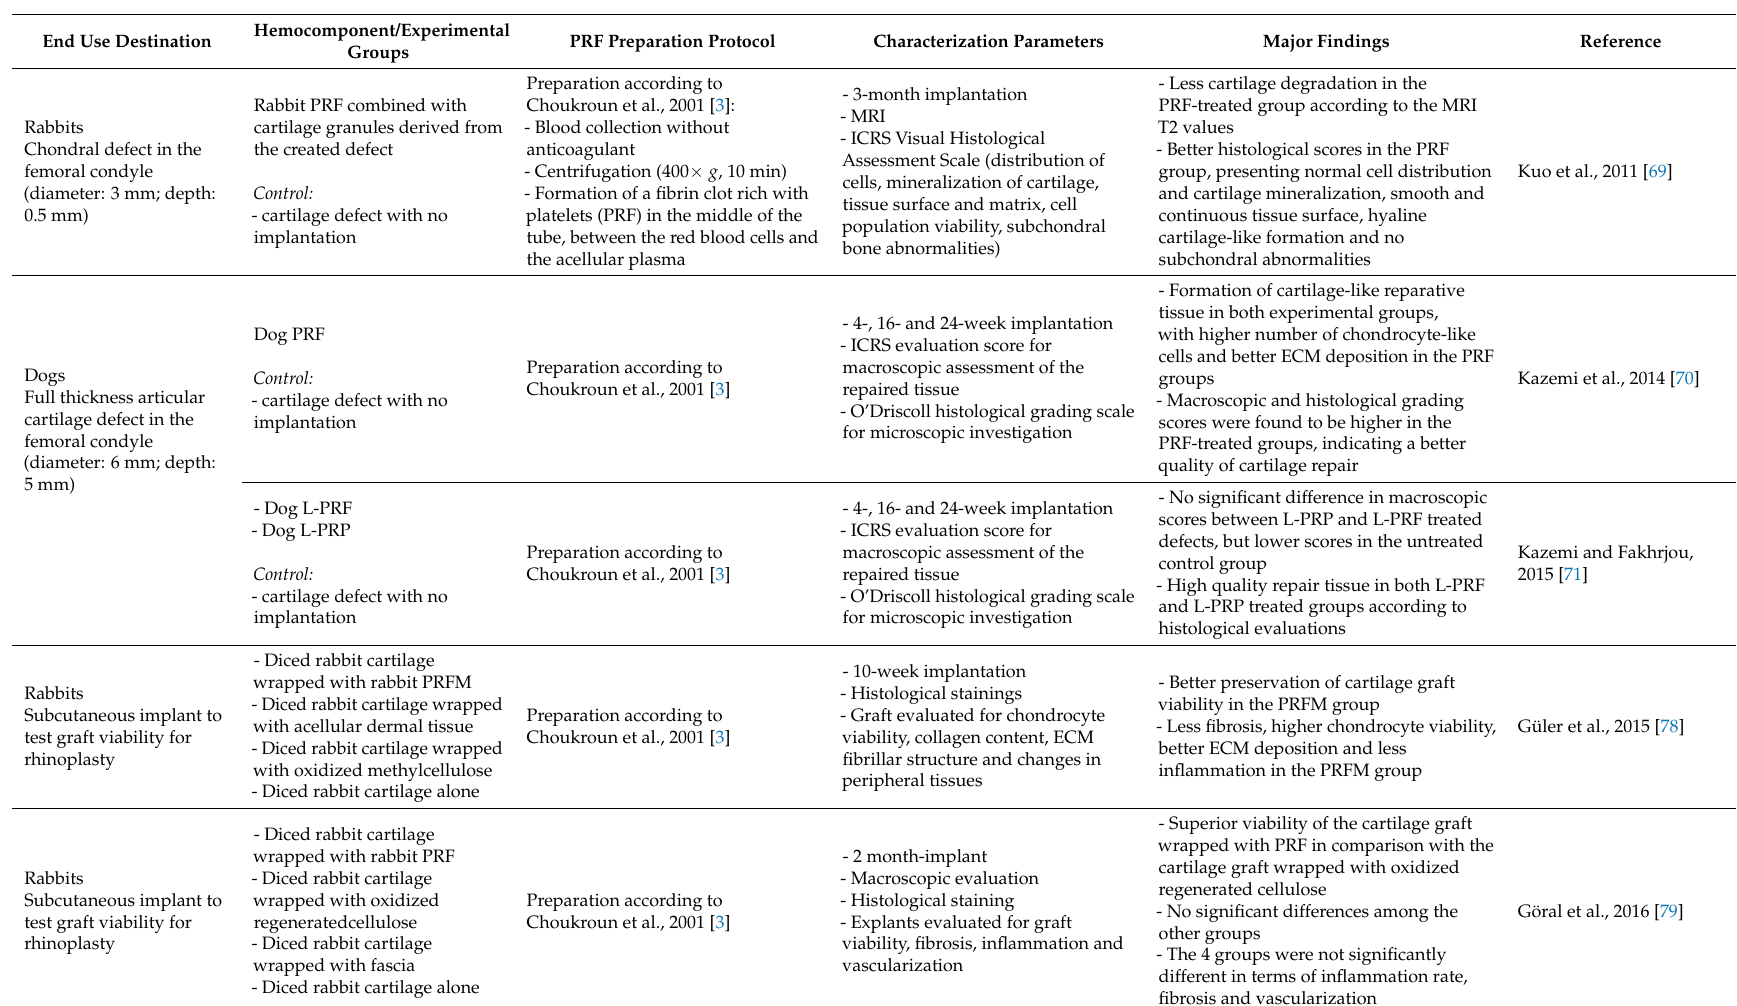
Table 2. Pre-clinical application of PRF for cartilage